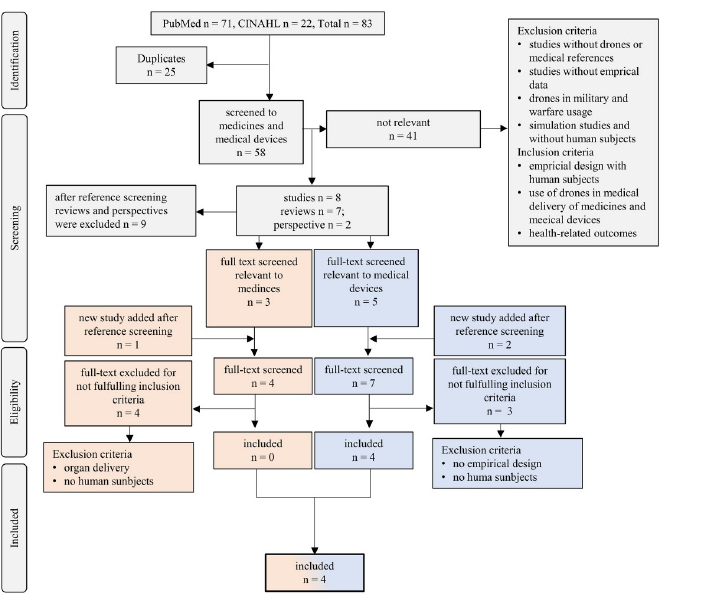
Fig 1. Frequency of exclusion